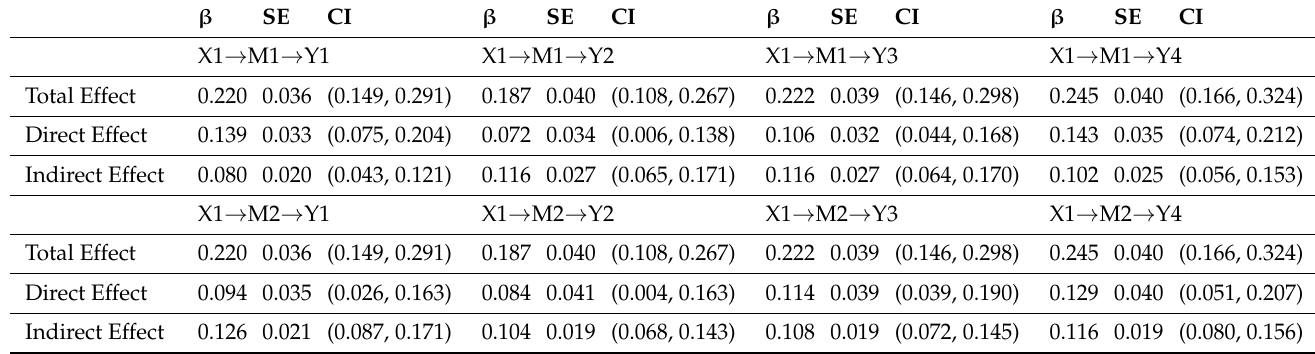
Table A1. Analysis of mediating effects based on appearance image.